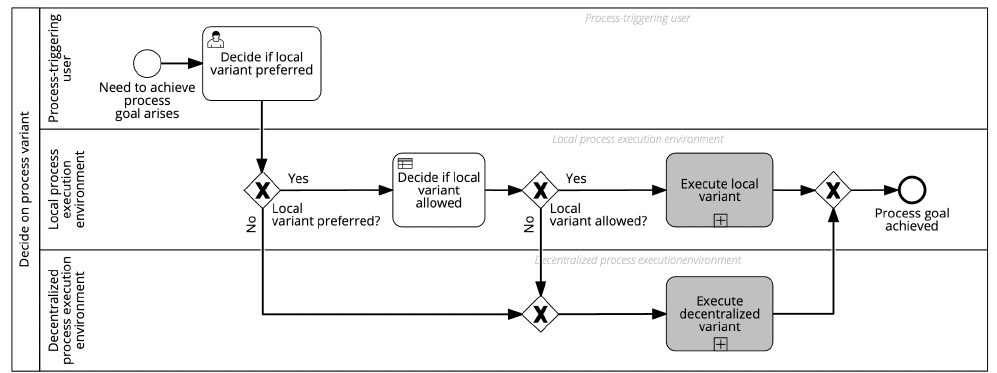
Figure 1. Business process model and notation (BPMN) diagram of the use case example for off-chain agent-based simulations (ABS): Deciding whether a request to bypass a decentralized process should be